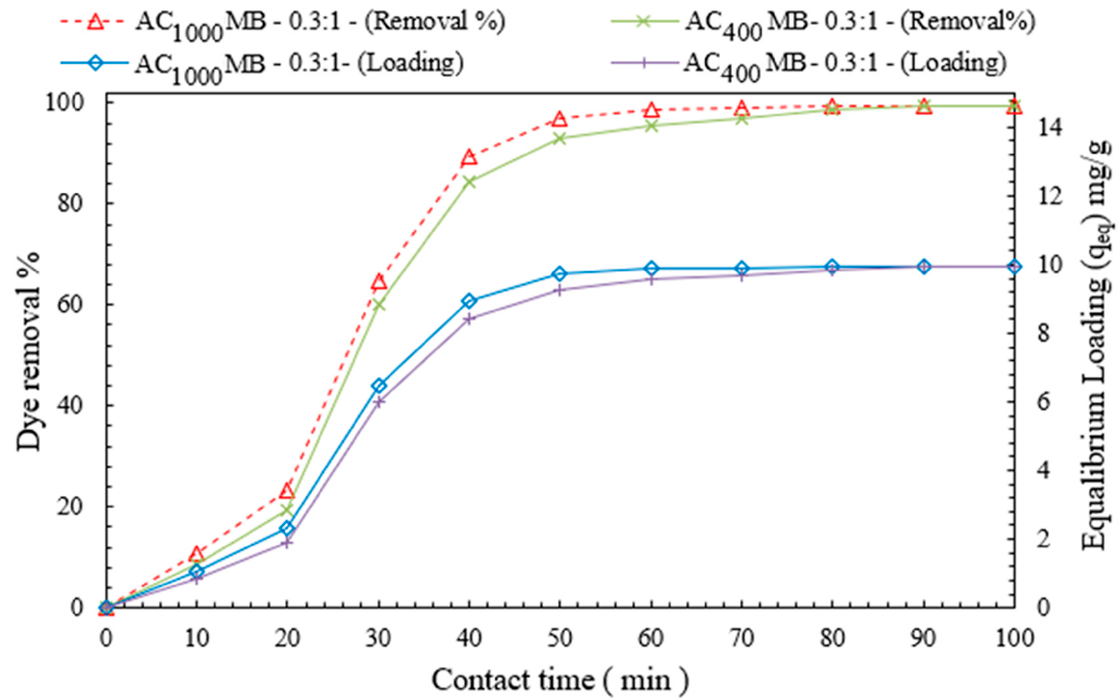
Figure 14. Effect of contact time on dye removal.